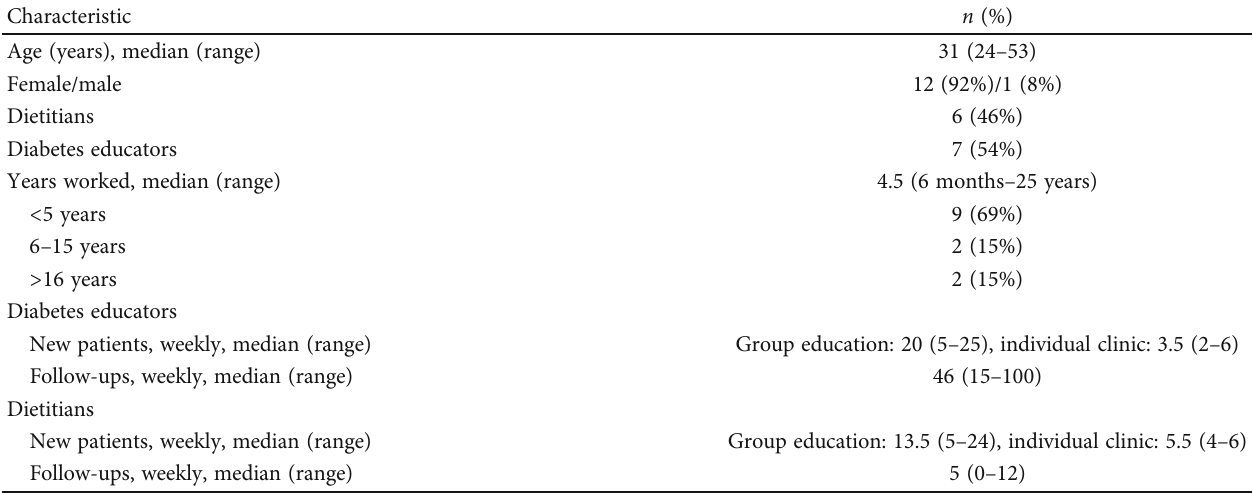
Table 1: Descriptive characteristics among the interviewed diabetes educators and